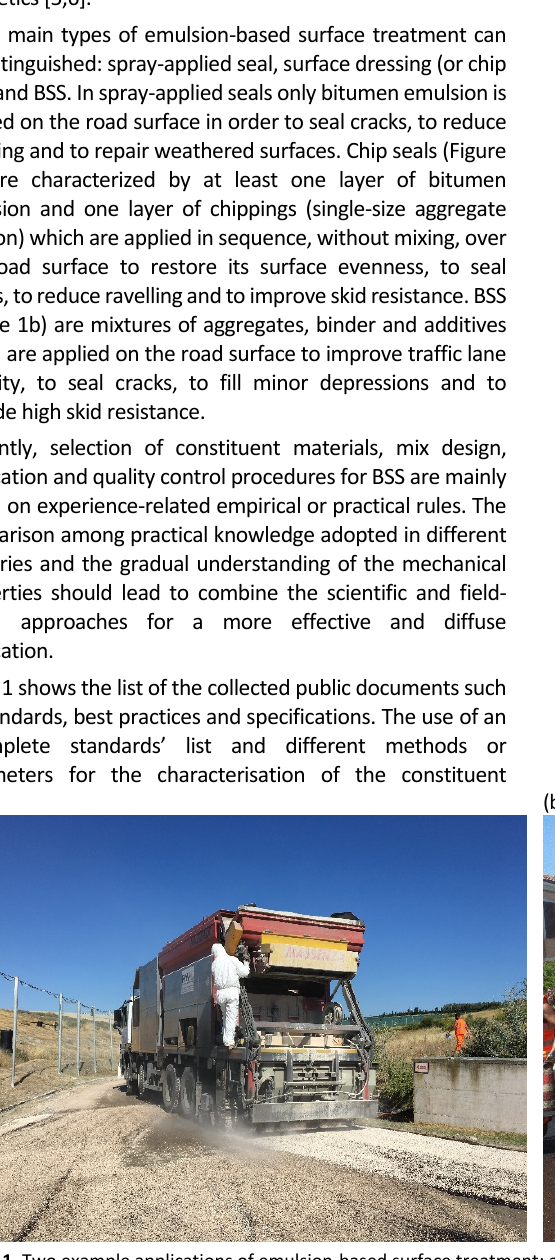
Figure 1 . Two example applications of emulsion ‐ based surface treatment: a) Surface dressing; b) Bituminous slurry